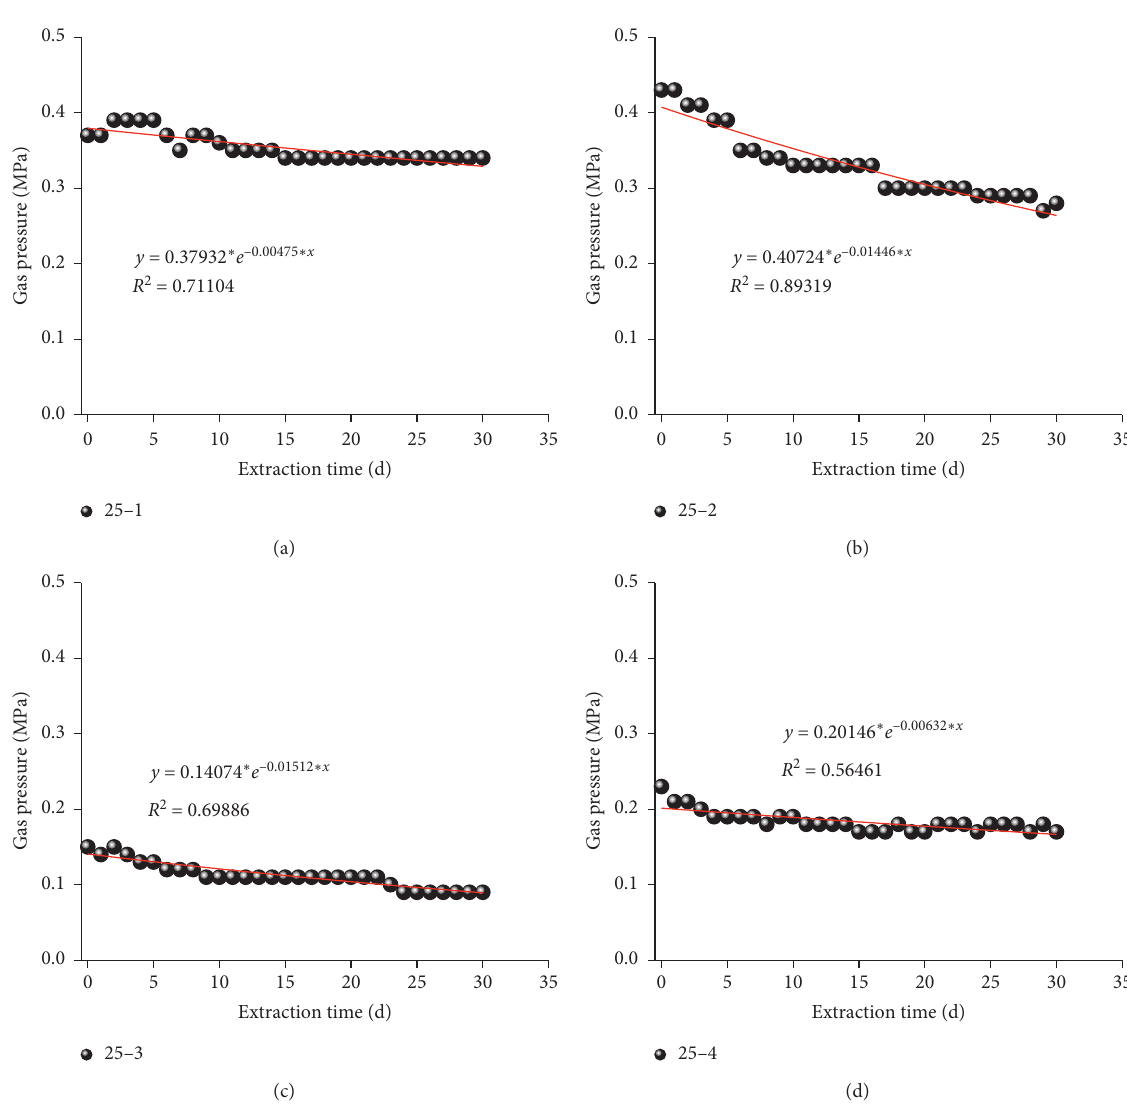
Figure 11: Pressure attenuation of test holes 1–4# in No. 25 drilling field.